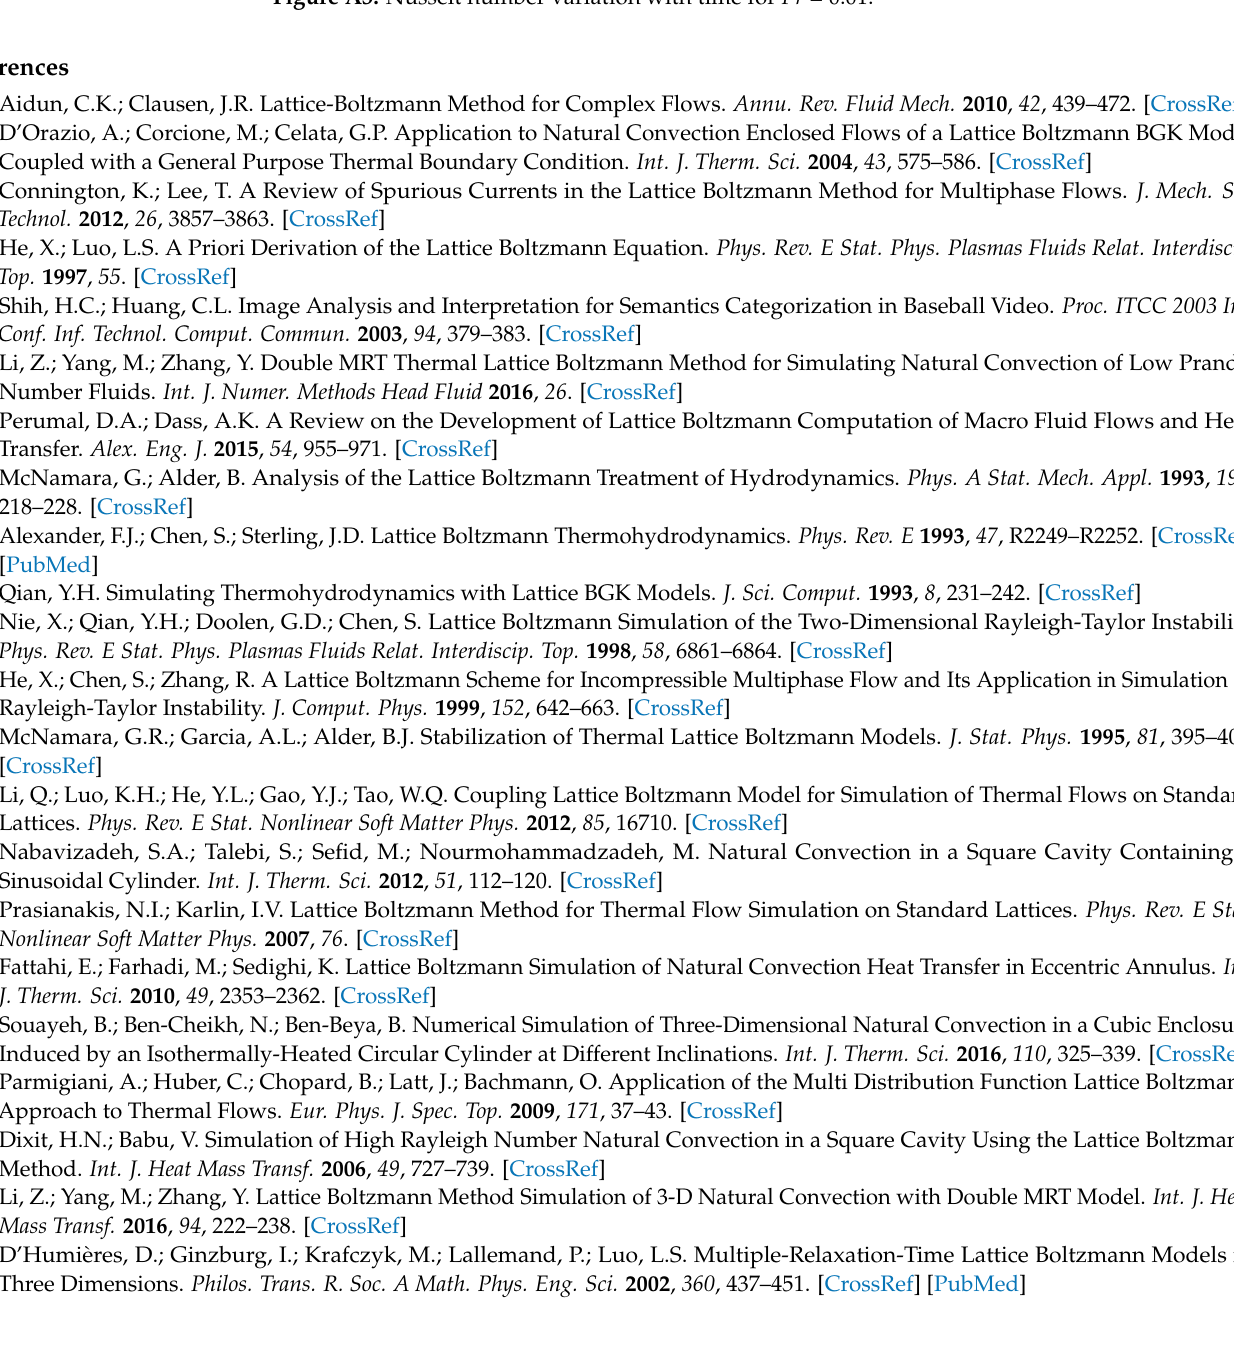
Figure A3. Nusselt number variation with time for Pr = 0.01.